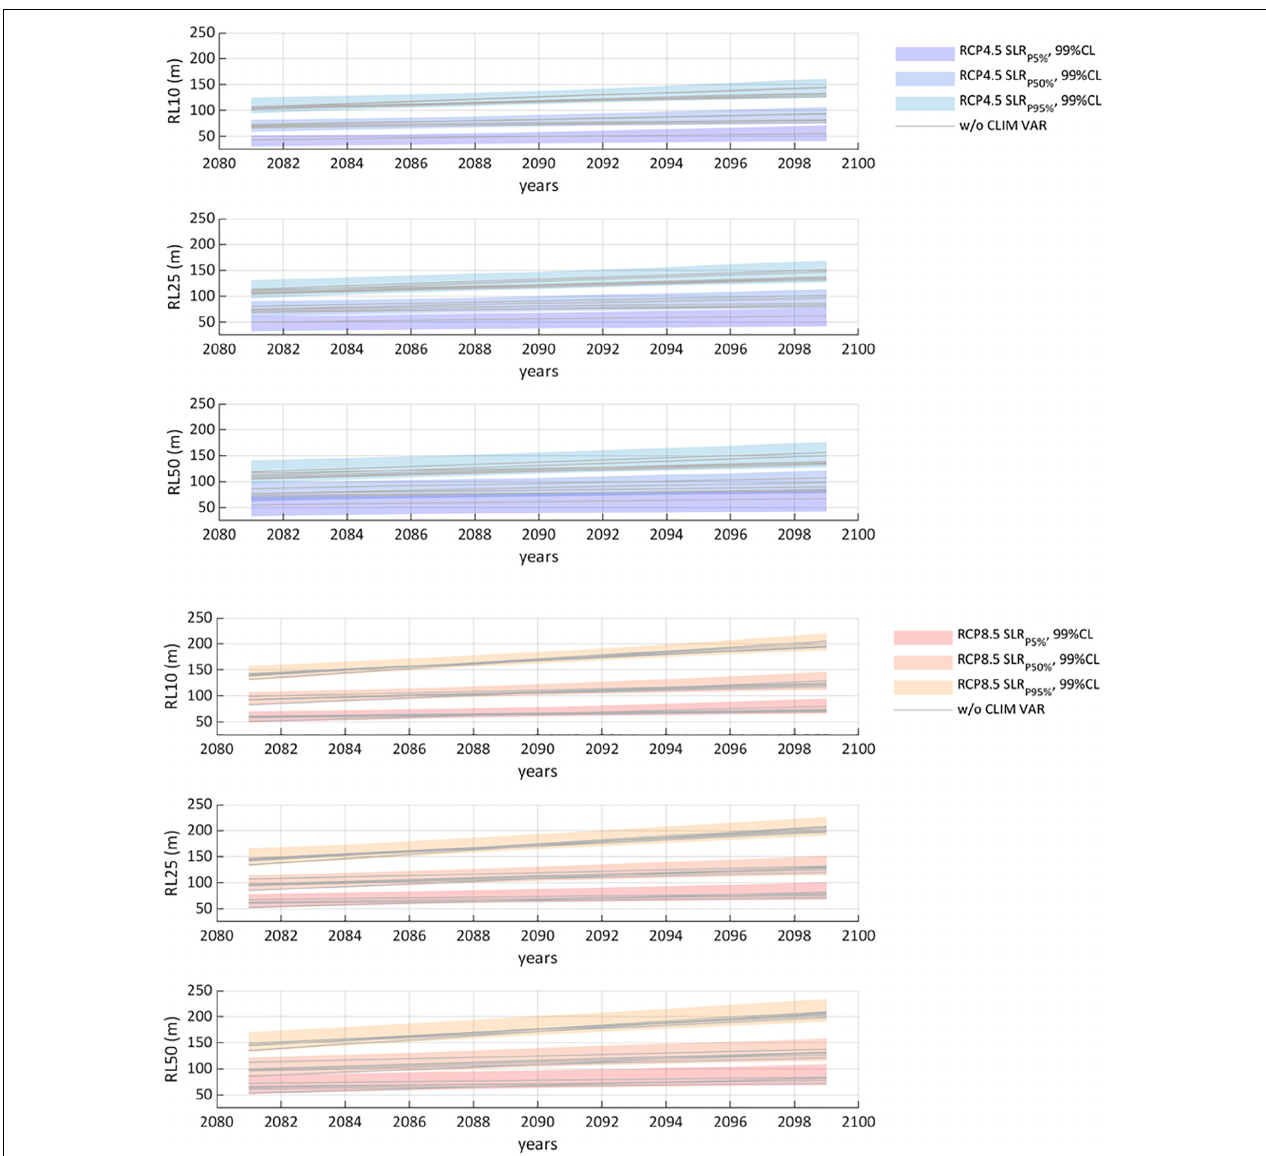
FIGURE 9 | Effective return levels corresponding to 10, 25, and 50 years under the non-stationary assumption for the period 2080–2100 and for the SLR trajectories (associated with the 5, 50, and 95th percentiles) under the RCP4.5 (blue panels) and the RCP8.5 (red panels). Grey solid lines represent the return periods calculated from the GCM-driven simulations of SP3 (without climate variability). Coloured shaded areas show the 99% confidence bands of the non-stationary GEV fit to the annual maxima shoreline retreats derived from SP1 simulations.